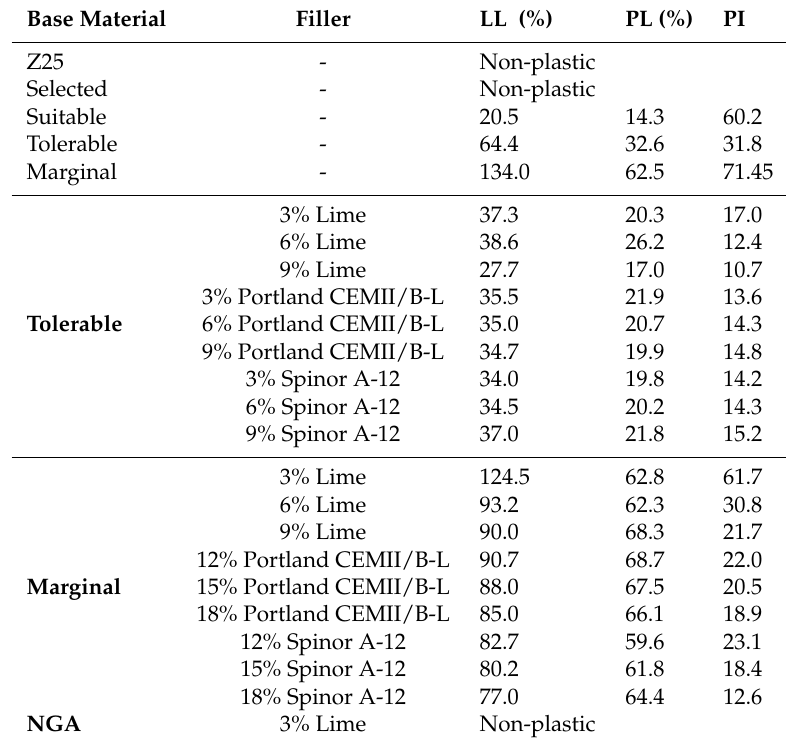
Table 4. Atterberg limits of classified and stabilized subbase materials used in this study. LL: Liquid Limit, PL: Plastic limit, PI: Plasticity